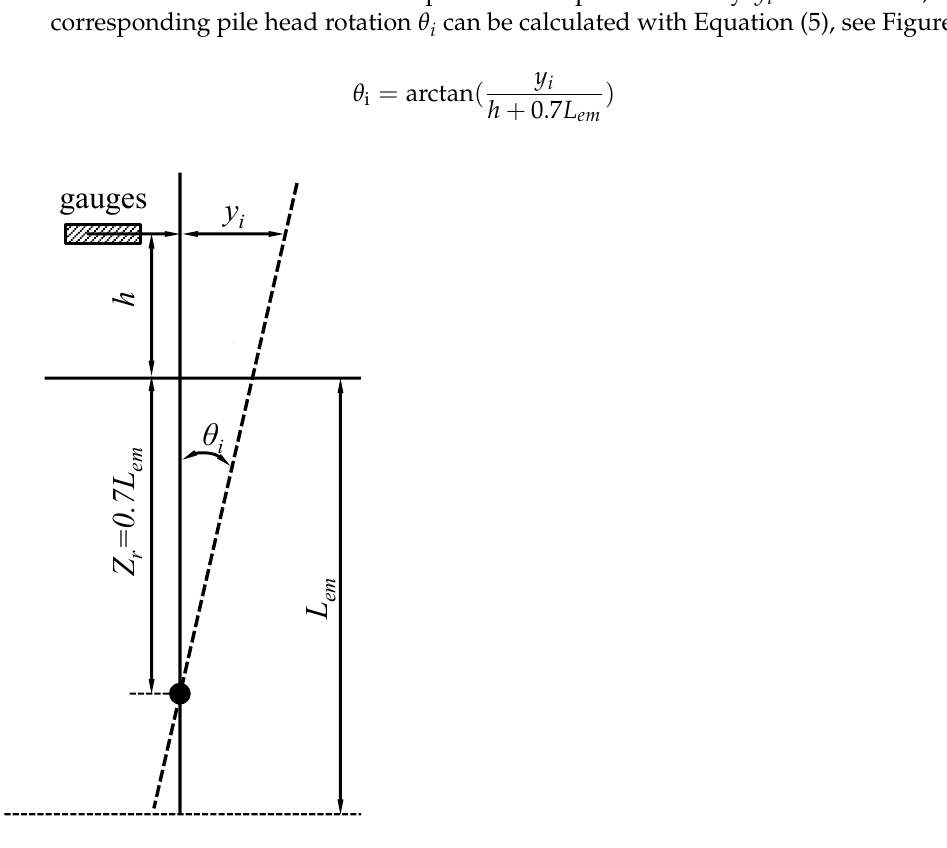
Figure 6. Sketch of pile rotation.